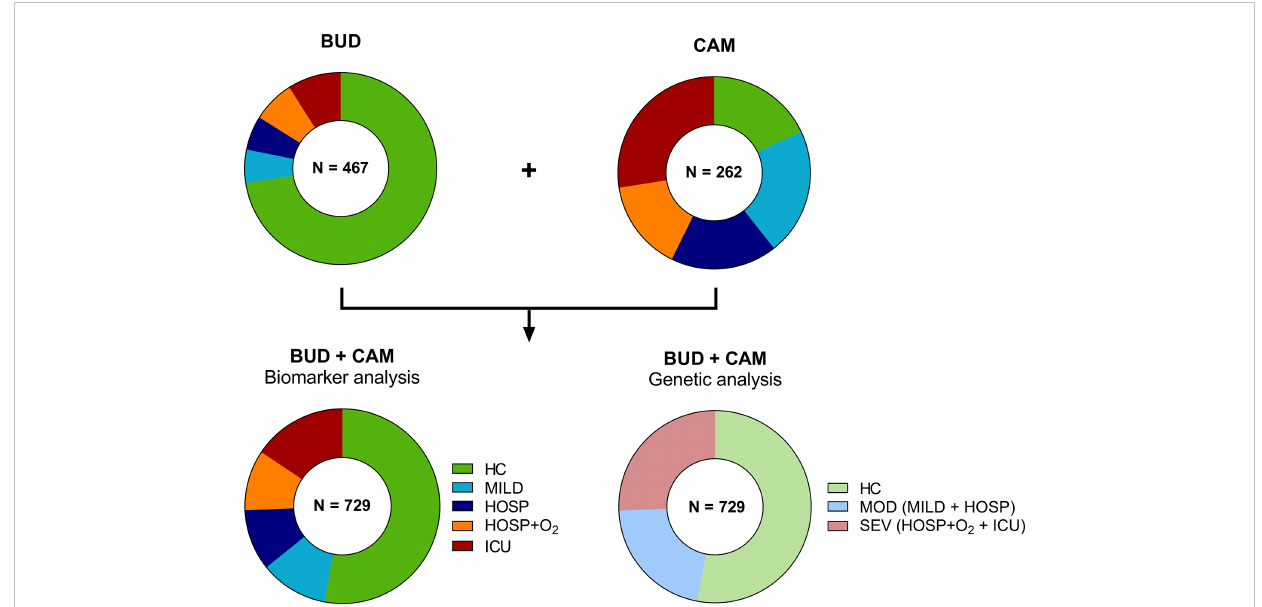
FIGURE 2 Distribution of cases and controls of the BUD and CAM cohorts for biomarker and genetic analysis. A total of 467 individuals were enrolled in Budapest (BUD), while 262 individuals were enrolled in Cambridge, UK (CAM). Individuals were strati fi ed according to fi ve severity groups for biomarker analysis (HC, MILD, HOSP, HOSP+O 2 , ICU), while genetic analysis were performed in only three severity groups (HC, MOD, SEV), merging MILD and HOSP into the moderate (MOD), and HOSP+O 2 and ICU into the severe (SEV) group. BUD, Budapest/Hungarian cohort; CAM, Cambridge cohort; N, number; HC, Healthy controls; MILD, patients not requiring hospitalization; HOSP, Hospitalized patients not requiring ventilation; HOSP +O 2 , Hospitalized patients requiring ventilation; ICU, Intensive care unit patients; MOD, moderate patients group; SEV, severe patients